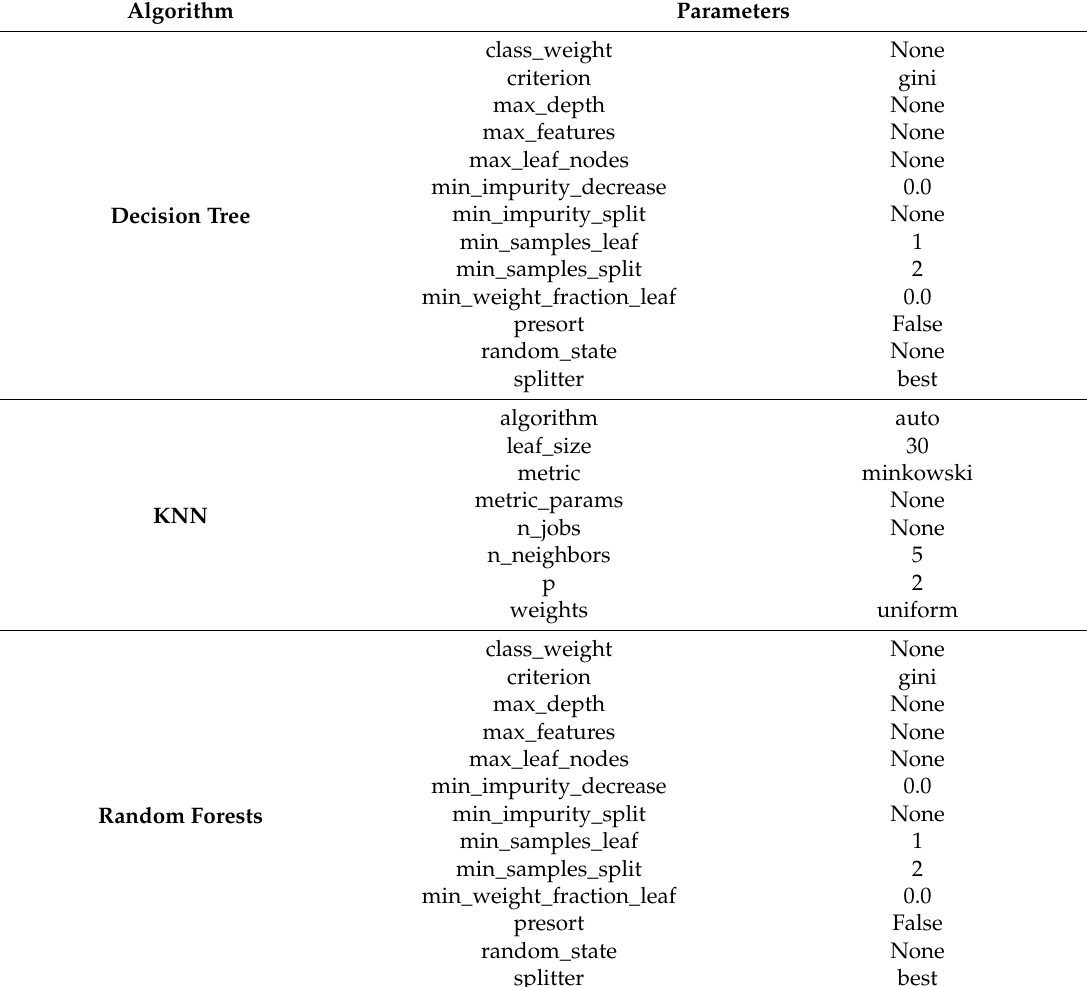
Table 6. The hyperparameters of competing